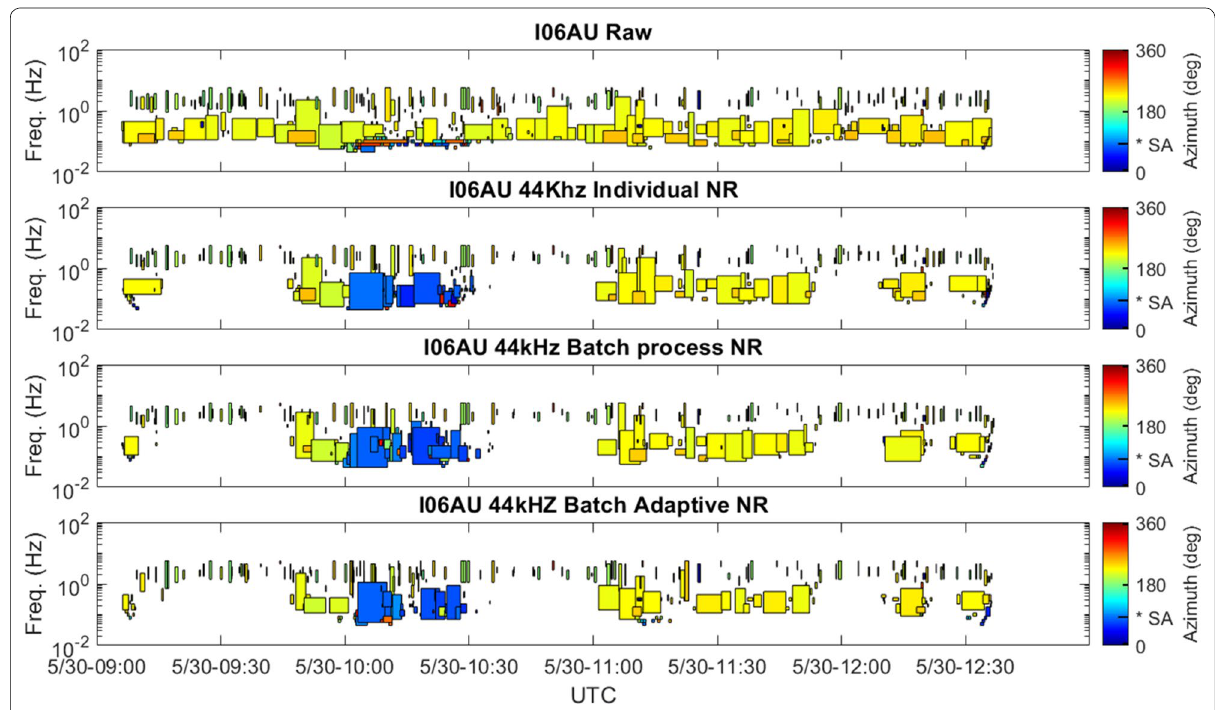
Fig. 2 Array processing results for all versions of the data using dtkPMCC. PMCC results shown are using the INFERNO filters. Each pixel is plotted and colored by calculated back azimuth, the known back azimuth of the source, 82°, is yellow in color and the average back azimuth of the microbarom, 220°, is blue. The frequency axis is plotted on a logarithmic scale. The array processing results are dominated by the microbarom but while the event is not overly obvious using the raw data, it became clear on the three types of pre-processed data. To evaluate the differences between the different results, we grouped the output into 5° azimuth bins and then we consider pixels within the bins on either side of the expected back azimuth. For the raw data processing there are 152 pixels in 5 families, while that number increases to 1369 pixels in 16 families, 1967 pixels in 20 families, and 1051 pixels in 11 families, for the individual noise reduction, batch noise reduction and batch adaptive runs,